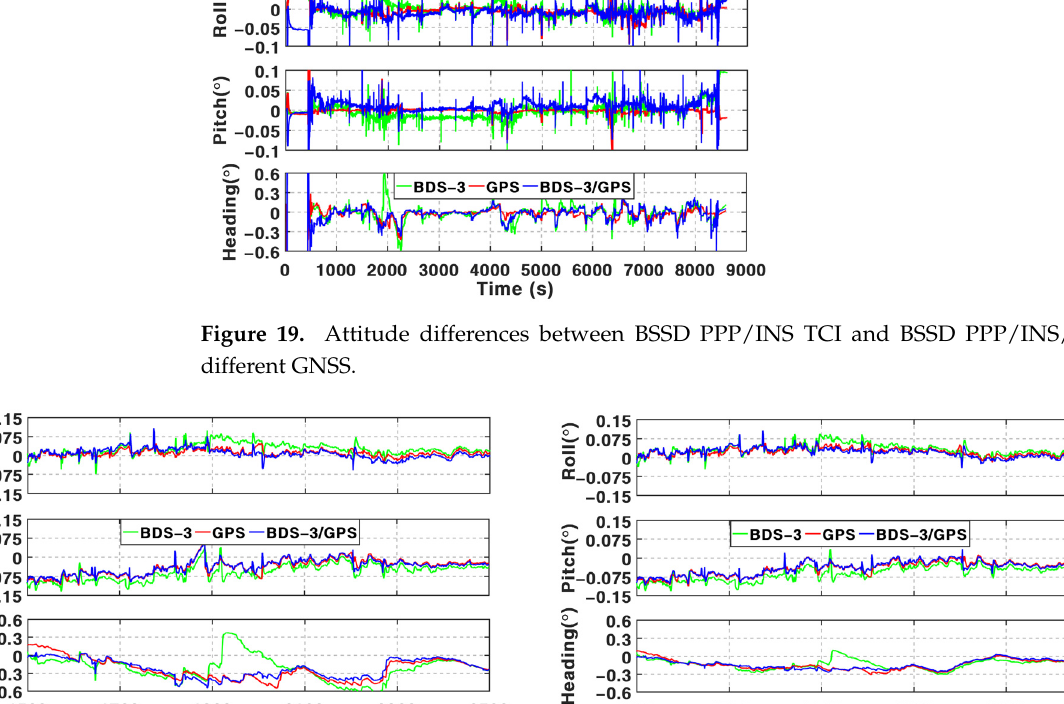
17 of 22 Figure 18. Attitude errors of BSSD PPP/INS TCI ( left ) and BSSD PPP/INS/ODO TCI ( right ) with different GNSS. Table 6. Attitude RMS of BSSD PPP/INS TCI with and without odometer aid. BSSD PPP/INS TCI